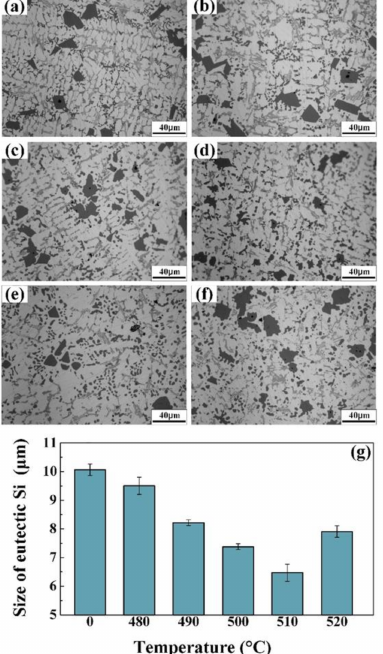
Figure 3. Microstructures of Al-13Si-5Cu-2Ni alloy solid solution treated at different temperatures for 8 h and 165 ◦ C aging for 10 h and the size of eutectic silicon of alloys: ( a ) as cast, ( b ) 480 ◦ C, ( c ) 490 ◦ C, ( d ) 500 ◦ C, ( e ) 510 ◦ C, ( f ) 520 ◦ C, and ( g ) the size of eutectic